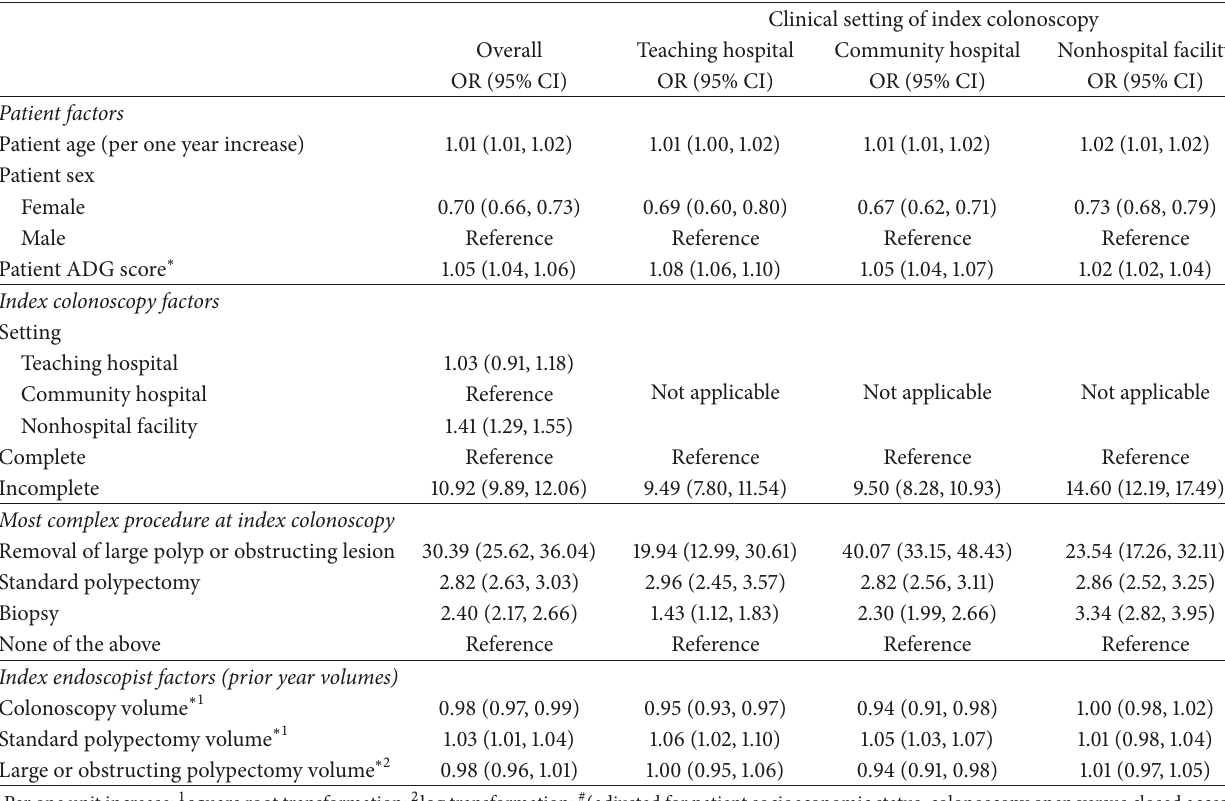
Table 3: Adjusted odds ratios for very early repeat colonoscopy #